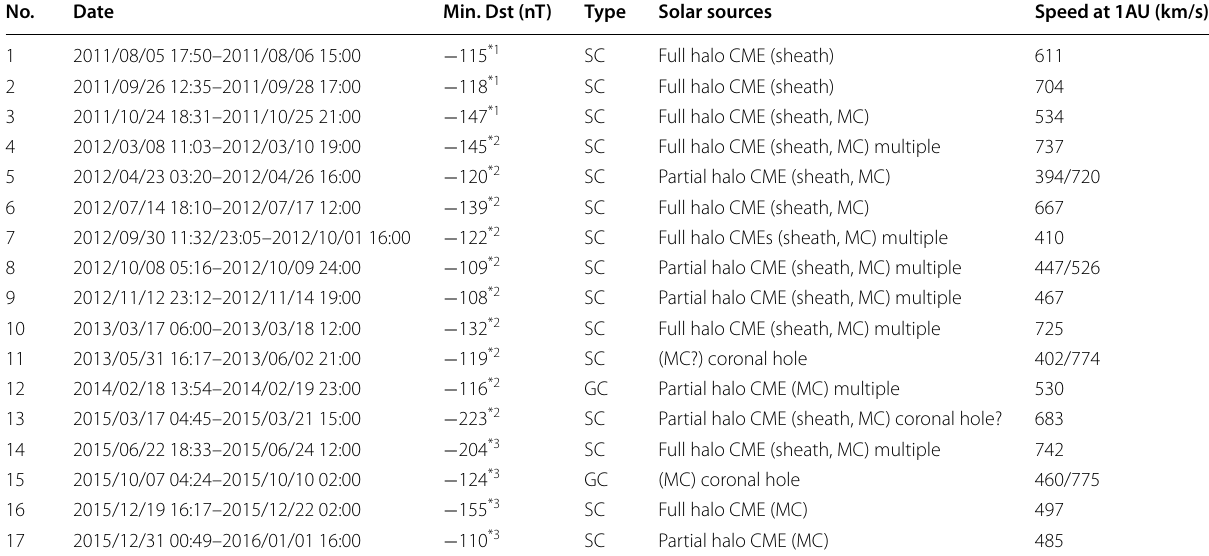
SC sudden commencement, GC gradual commencement, MC magnetic cloud